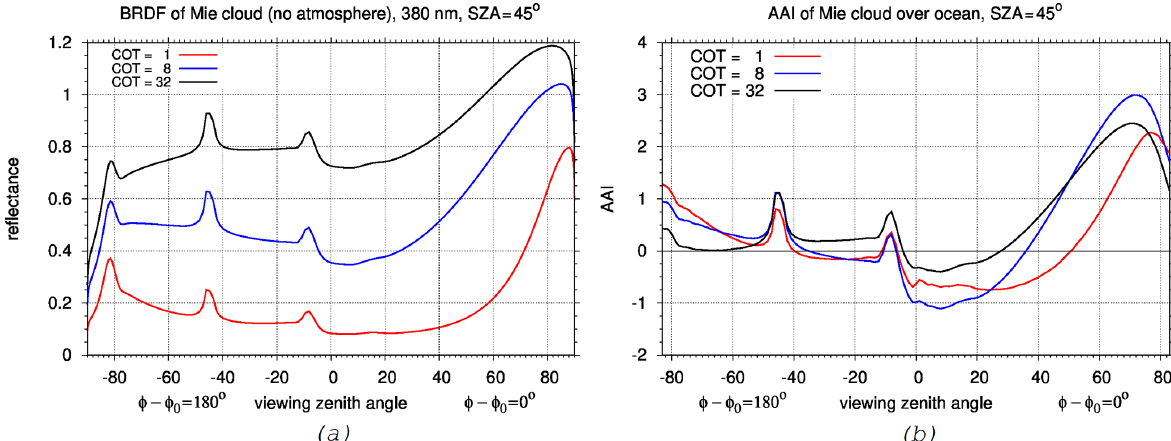
Figure 7. (a) Simulated BRDF of a Mie scattering cloud (without atmosphere) as a function of viewing zenith angle in the principal plane for three cloud optical thickness (COT) values: 1, 8, and 32. (b) Simulated AAI of a Mie scattering cloud inside the atmosphere as a function of viewing zenith angle in the principal plane for the same three COT values. The geometric cloud fraction is 1. The solar zenith angle is 45 ◦ . The relative azimuth angle is defined as 0 ◦ for forward scattering and 180 ◦ for backward